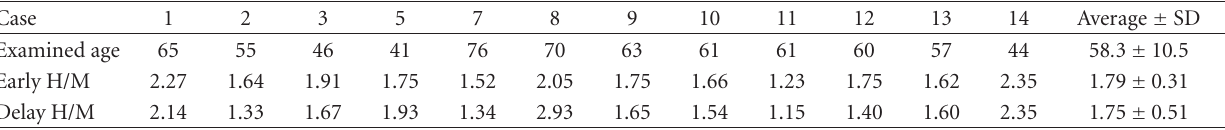
Table 2: The findings of 123 IMIBG myocardial scintigraphy in PARK2